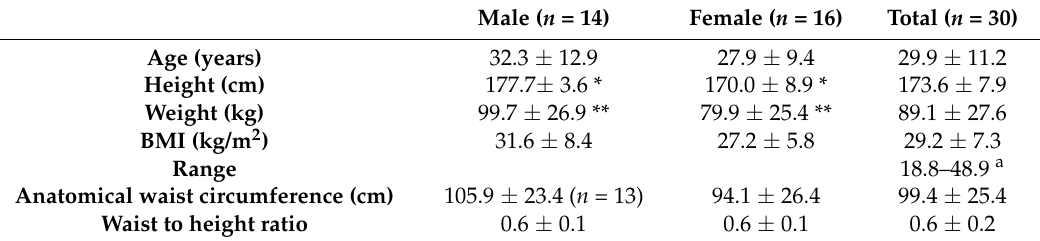
Table 1. Participant characteristics (mean ± standard deviation).